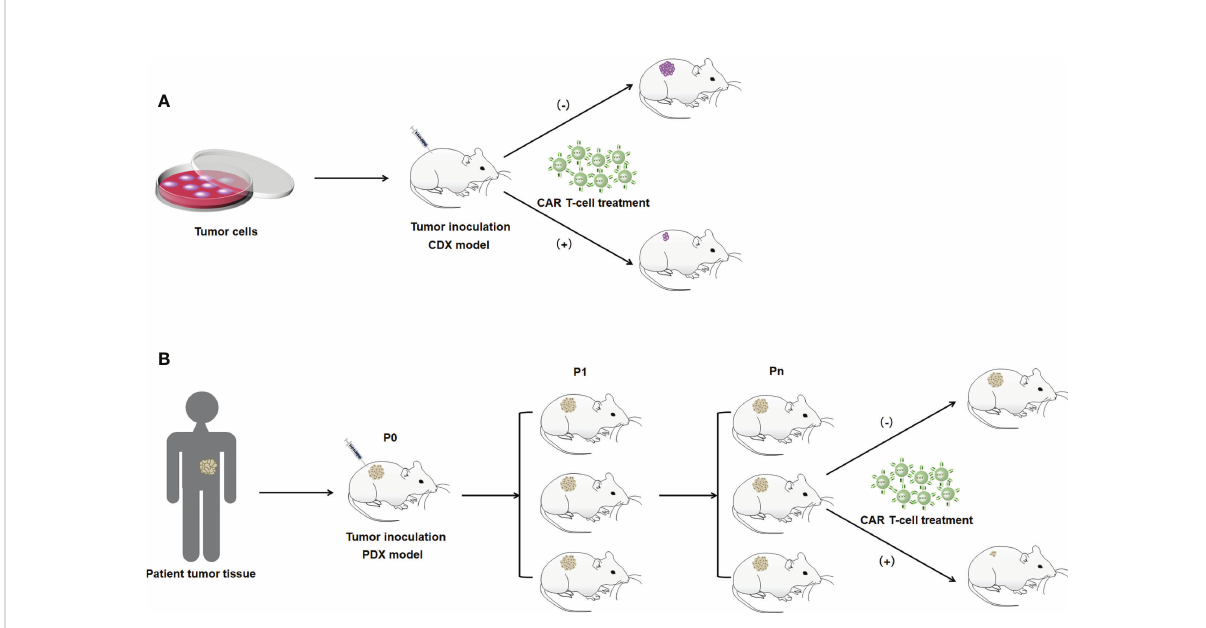
FIGURE 2 Illustration of the construction method of the xenograft model. (A) CDX model. (B) PDX model. P0 indicates mice directly inoculated with patient tumor tissue. P1 indicates mice with tumor tissues isolated from P0 generation mice for transplantation into the body. Pn indicates the Nth generation of mice passed on in accordance with the abovememtioned